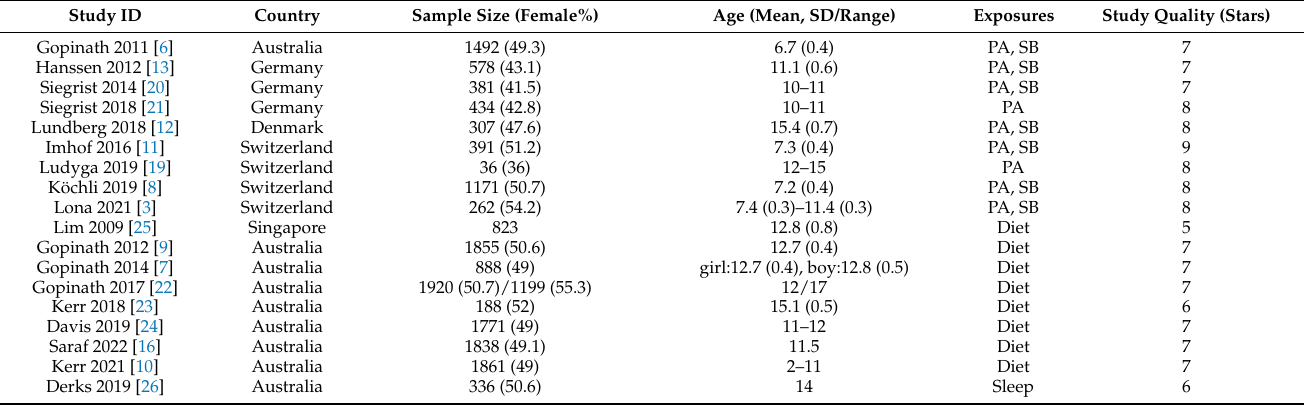
Table 1. Study characteristics of those reporting RVC and lifestyles for children and